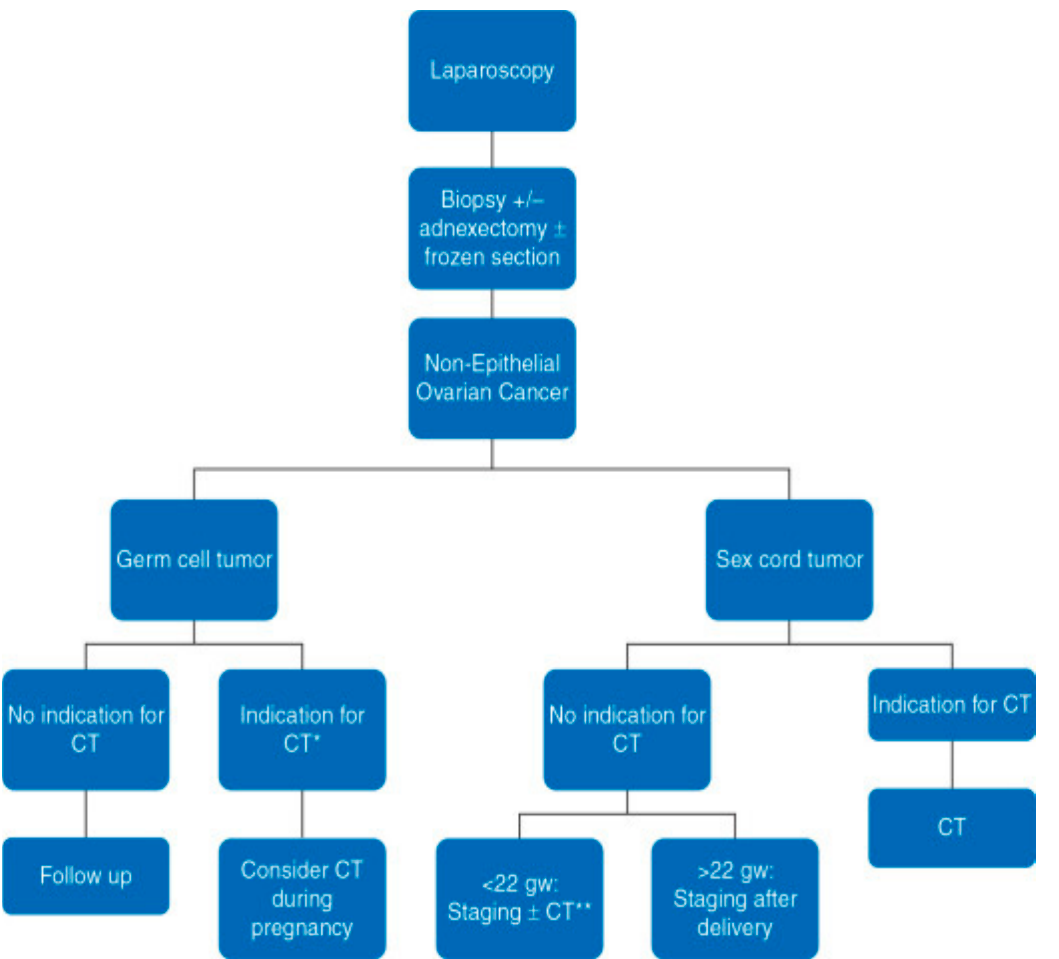
Figure 2. Scheme for the management of nonepithelial ovarian cancer tumors. Staging refers to surgical staging. CT, chemotherapy; gw, gestational weeks. * According to ESMO guidelines; ** CT administered according to restaging surgery findings (Reprinted with permission from Amant, F.; Berveiller, P.; Boere, I.A.; Cardonick, E.; Fruscio, R.; Fumagalli, M.; Halaska, M.J.; Hasenburg, A.; Johansson, A.L.V.; Lambertini, M.; et al. Gynecologic cancers in pregnancy: Guidelines based on a third international